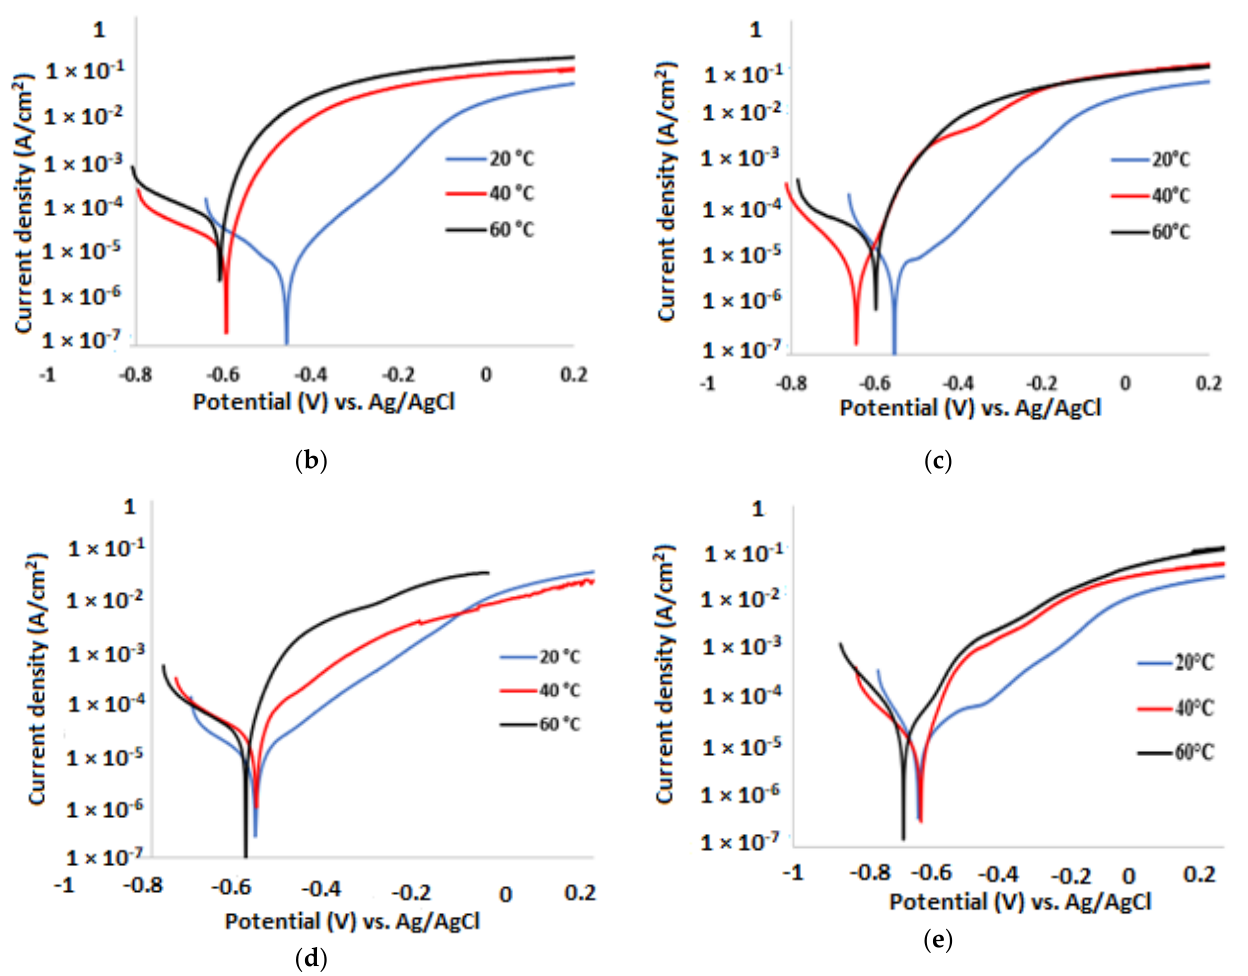
Figure 3. Potentiodynamic polarisation curves of mild steel in 3.5% NaCl solution with ( a ) MS without inhibitor, ( b ) Ce ( acac ) , ( c ) Ce ( hfac ) , ( d ) La ( acac ) , and ( e ) La ( hfac ) inhibitor.